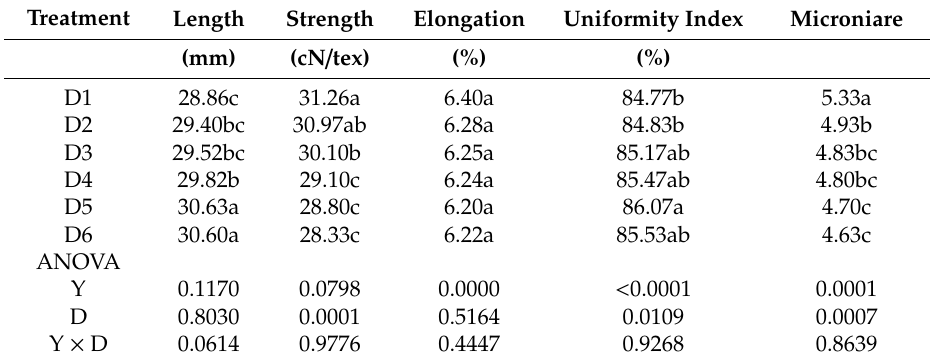
Table 10. Comparison of fiber quality parameters of various densities of growing seasons 2016 and 2017.